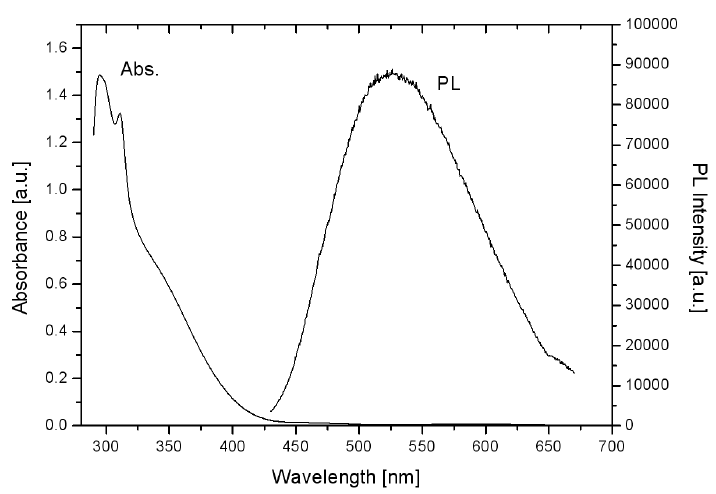
Fig. 4 UV-visible absorption and photoluminescence (PL) spectra of the PAI 1 polymer films: thin film on glass plate was used for UV-Visible measurement and free standing film (thickness around 40 µ m) was used for PL measurement. The excitation was at 350